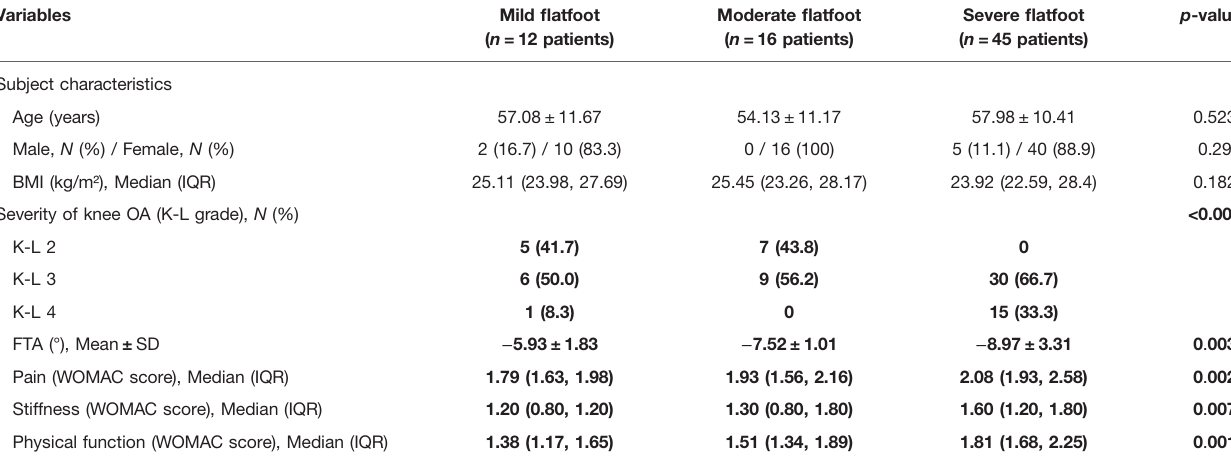
TABLE 3 | Participant-level characteristics of the research population based on the severity of fl atfoot ( n =76).